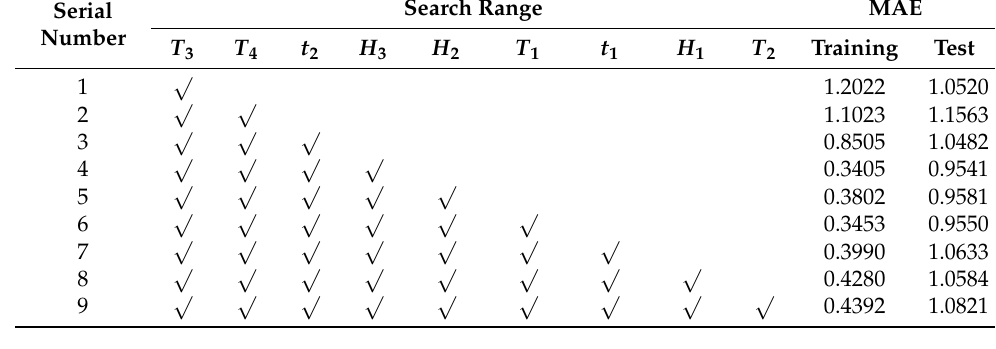
Table 3. Evaluation of simulation results for different input factors.